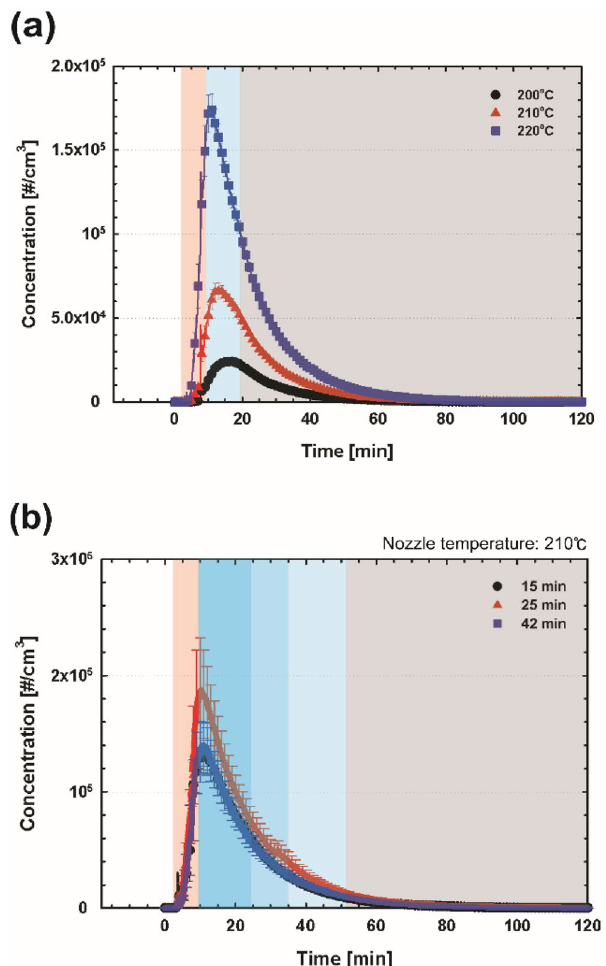
Figure 7. Concentrations of emissions from the PLA filament for different ( a ) nozzle temperatures and ( b ) printing times measured using a CPC. The red, blue, and gray shaded areas represent the process of nozzle heating, printing, and cleaning, respectively.